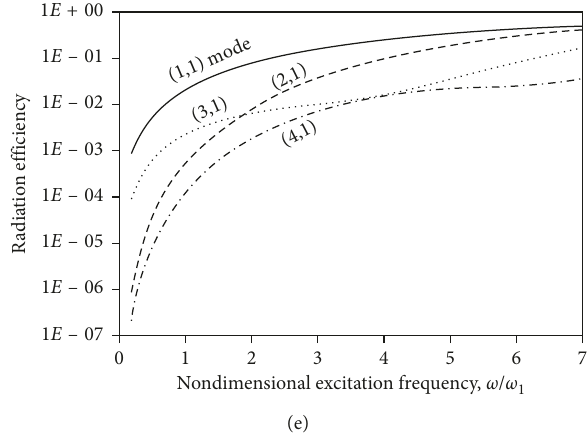
Figure 3: (a) Symmetric and (c) antisymmetric vibration amplitude versus excitation frequency for various source excitation magnitudes ( a 3m, b c 0.5m, ξ 0.02, and N 4); (b) symmetric and (d) antisymmetric sound radiation versus excitation frequency for various (cid:31) (cid:31) (cid:31) (cid:31) (cid:31) source excitation magnitudes ( a 3m, b c 0.5m, ξ 0.02, and N 4); (e) radiation efficiency versus excitation frequency for various (cid:31) (cid:31) (cid:31) (cid:31) (cid:31) structural